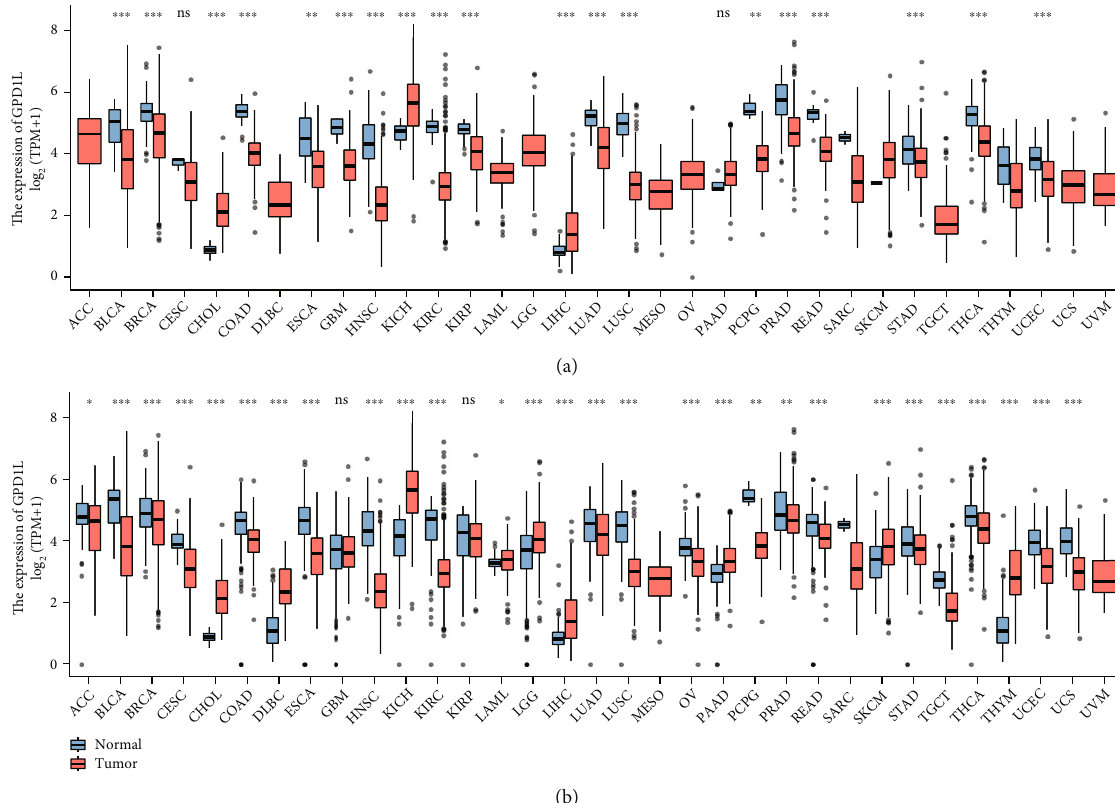
Figure 1: GPD1L levels that are either higher or lower in various malignancies when compared with normal tissues in (a) the TCGA datasets and (b) the TCGA and GTEx database. ∗ p < 0 : 05 , ∗∗ p < 0 : 01 , ∗∗∗ p < 0 : 001 ; ns: no signi fi